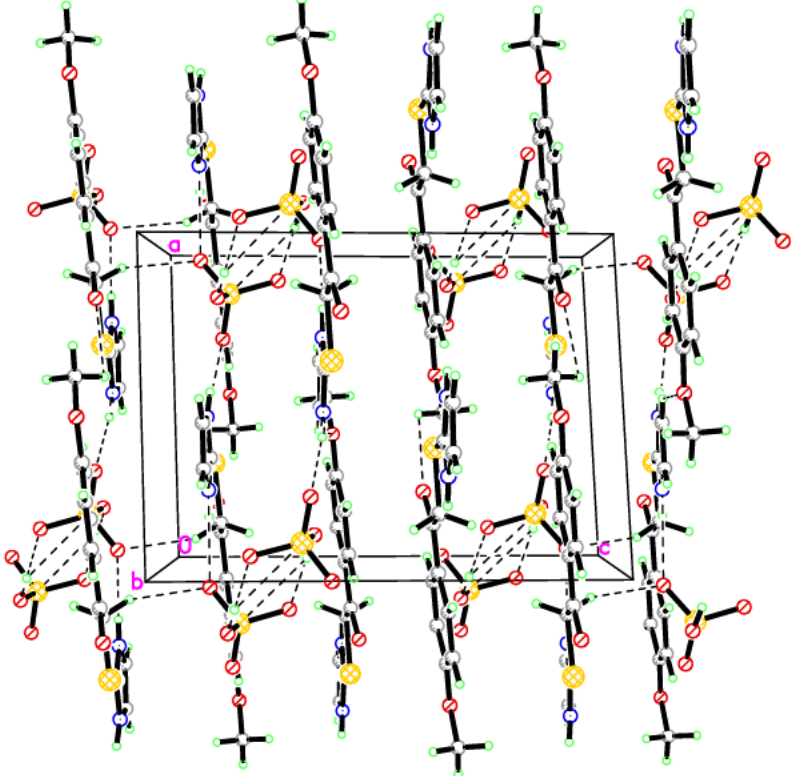
Figure 3. Molecular packing for imidazole sulfate-salt 9b, showing hydrogen bonds that were drawn as dashed lines forming a network structure.